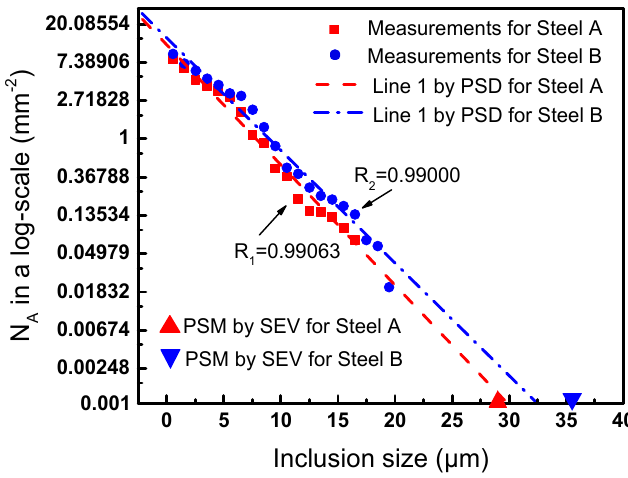
Figure 14. Comparison of regression lines by PSD (PMS by PSD is represented as the intersection between the line and X-axis) and PMS by SEV when only Al 2 O 3 -MnS is taken into consideration for Steels A and B.